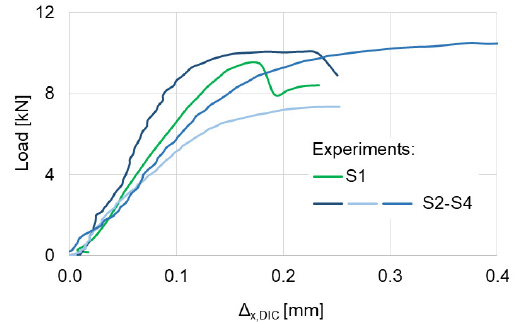
Figure 3. Results of the shear-parallel-to-grain test according to the standard ASTM D143-94 [1]: load vs. DIC relative vertical displacement ∆ x,DIC . [3] curves S2-S4 exhibit plateau. Despite not being plot- ted in this figure, all the curves S1-S4 end with sudden drops, which are associated with an unstable fracture propagation. The Table 1 lists the obtained values of the shear strength f ASTM xy